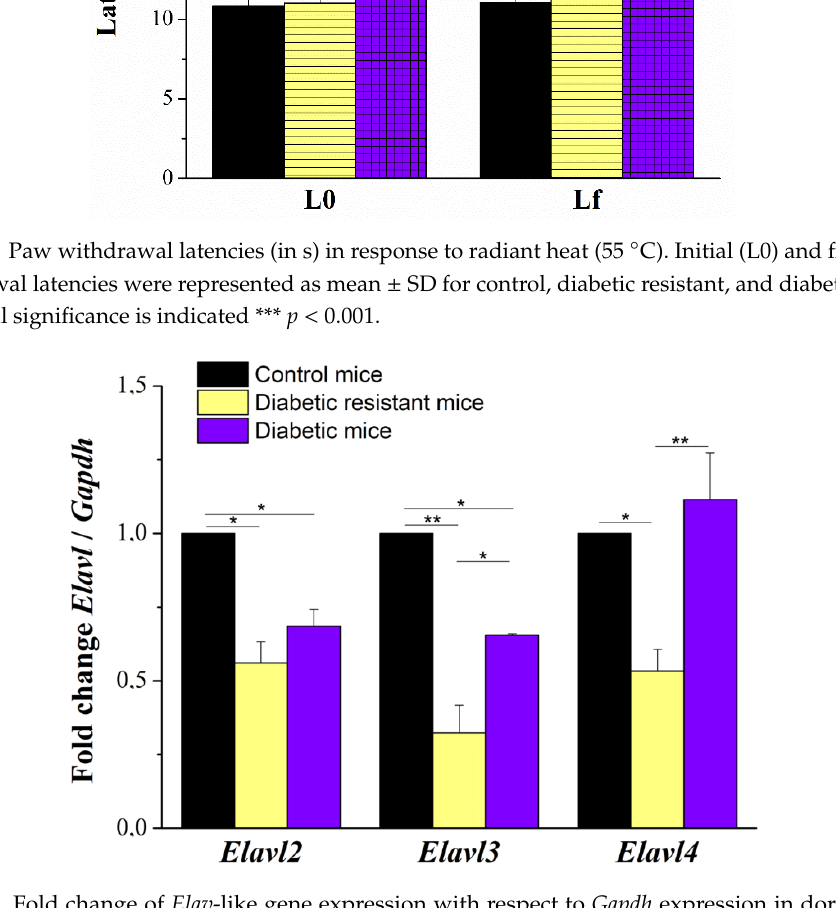
Figure 4. Fold change of Elav -like gene expression with respect to Gapdh expression in dorsal root ganglia (DRG) neurons of control, diabetic resistant, and diabetic mice. Statistical significance is indicated * p < 0.05, ** p < 0.01.